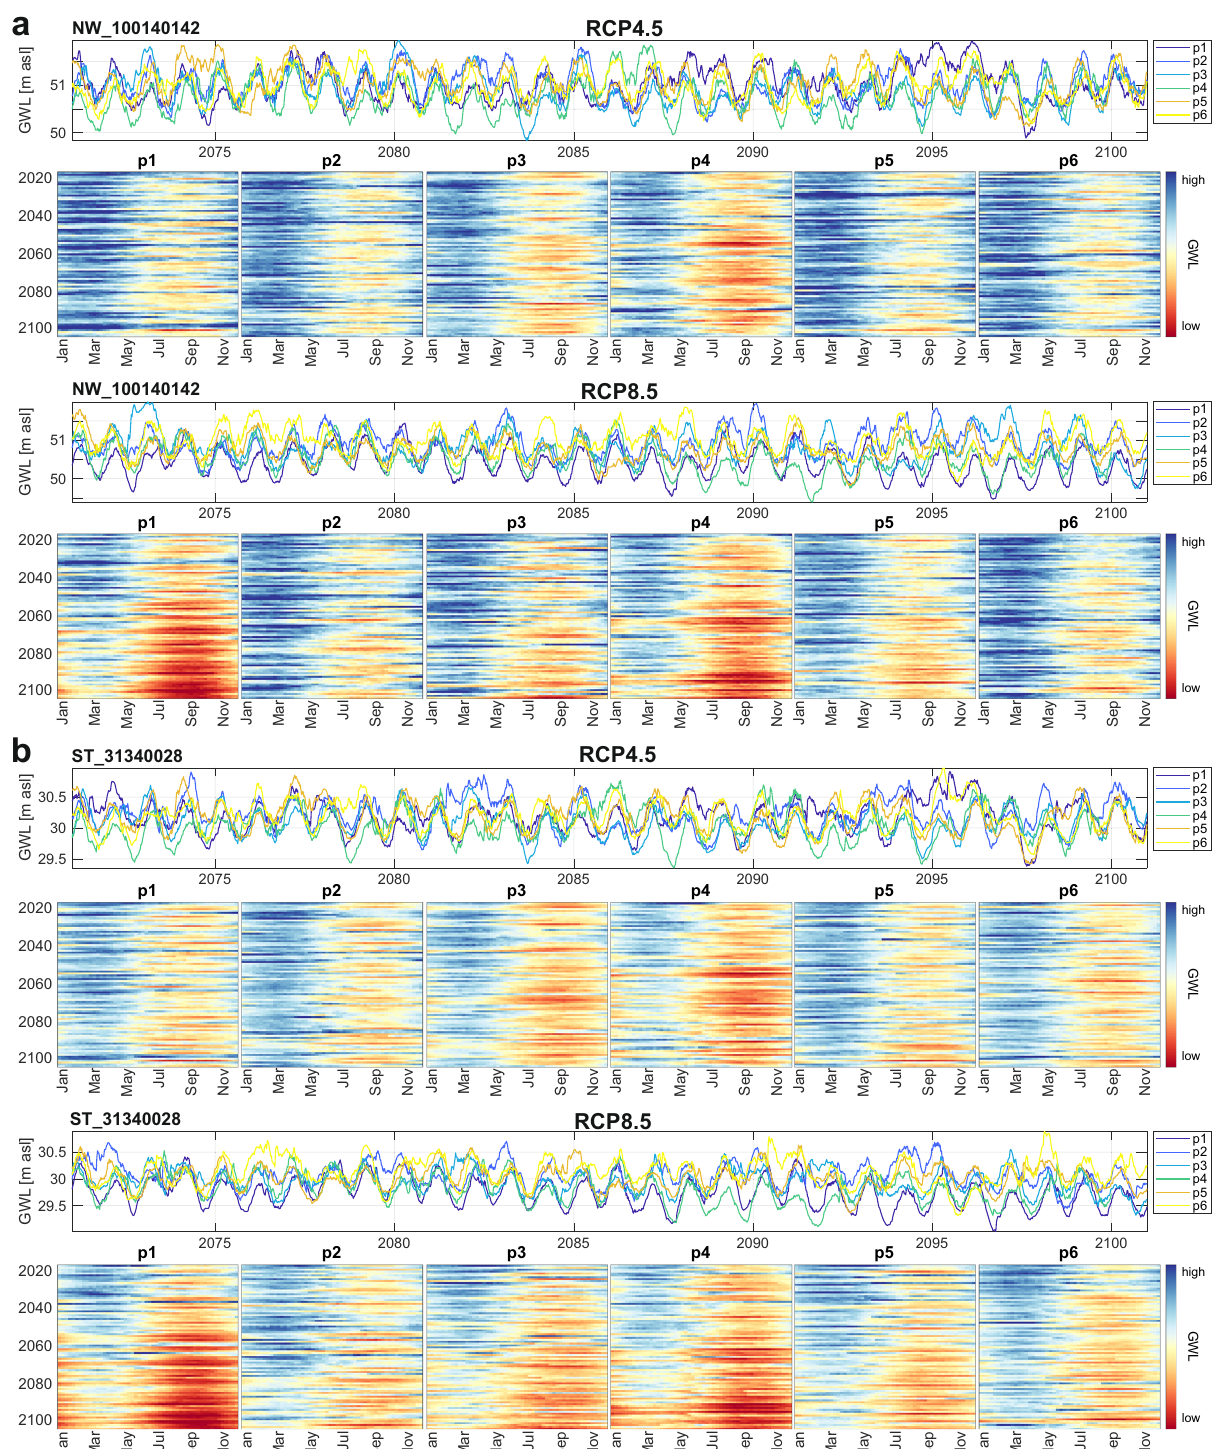
Fig. 3 Heatmap plots and far future groundwater levels. RCP4.5 and RCP8.5 results for two arbitrarily selected sites marked by black boxes in Fig. 1 (a NW_100140142, b ST_31340028). Heatmap plots show the whole simulation period for each of the projections under each of the considered scenarios. Columns of each plot as weeks during the year and rows as the year (top: 2014 — bottom: 2100).